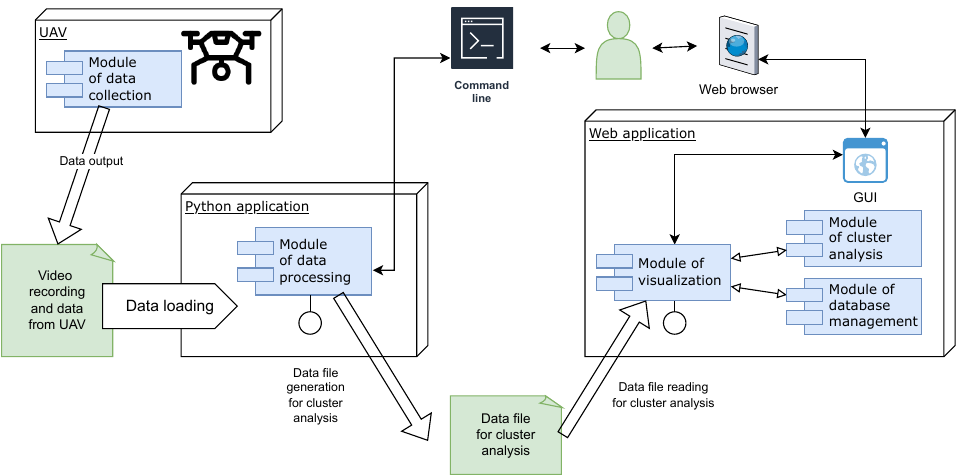
Figure 2. Component diagram of the designed